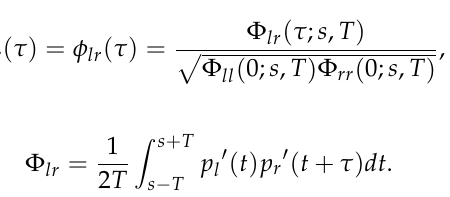
Cutting as a human-generated sound. The definitions of τ 1 , ϕ 1 , W Φ (0) and the IACC are